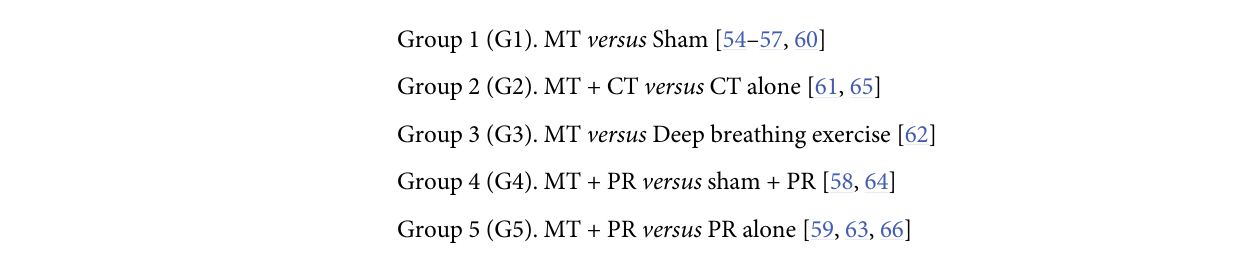
Fig 1. Flowchart for the identification and screening of eligible studies.